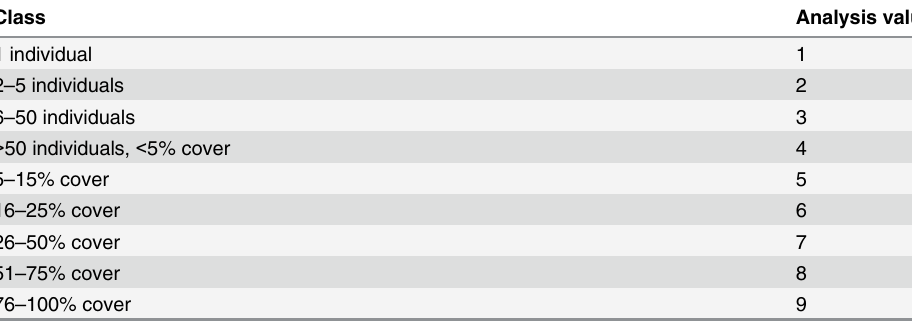
Table 2. Different classes with corresponding analysis